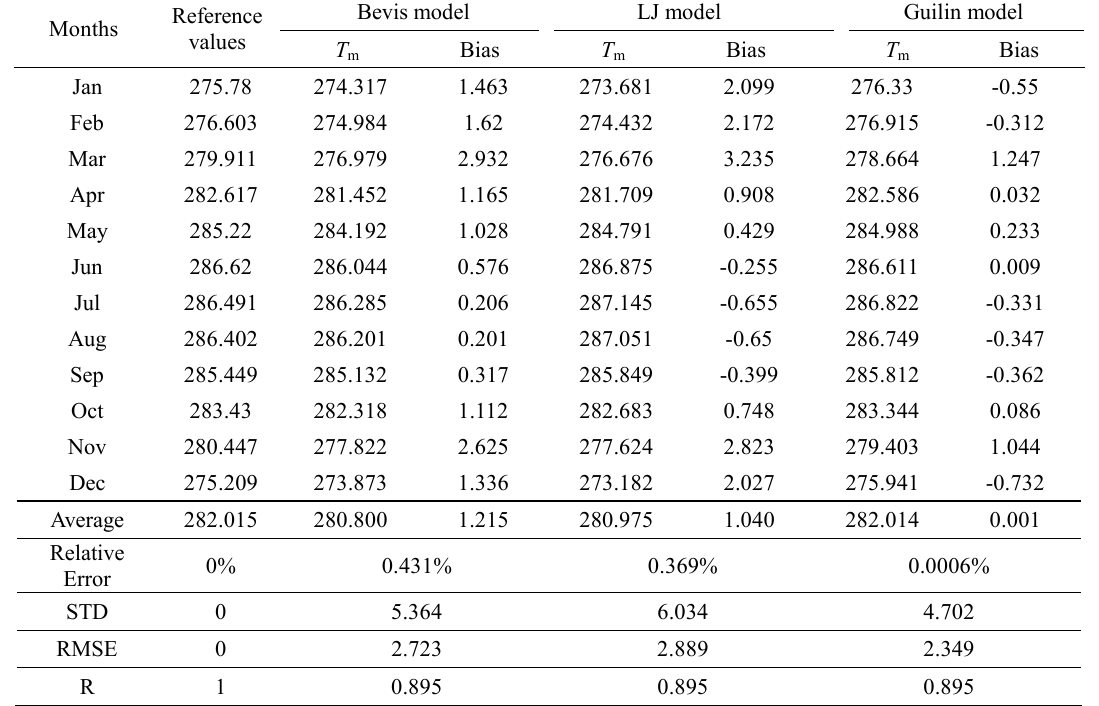
Table 3. Comparison of T m accuracy calculated by 3 models of Guilin station in 2017